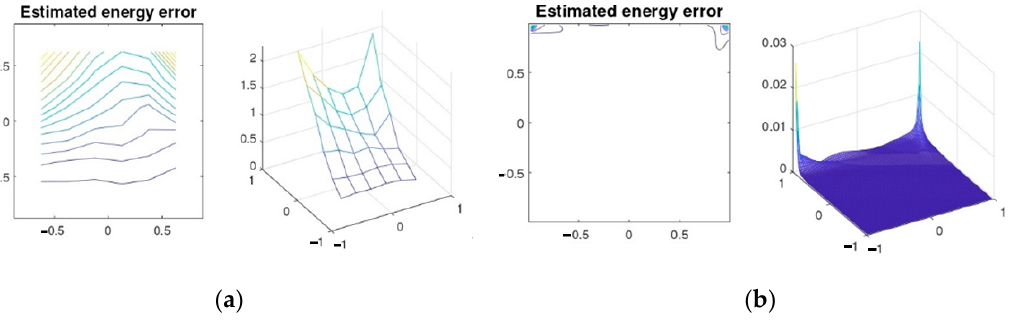
Figure 9. Error associated with a 16 × 16 and a 256 × 256 square grid, Q 2 – P 1 approximation. ( a ) 16 × 16 elements; ( b ) 256 × 256 elements.